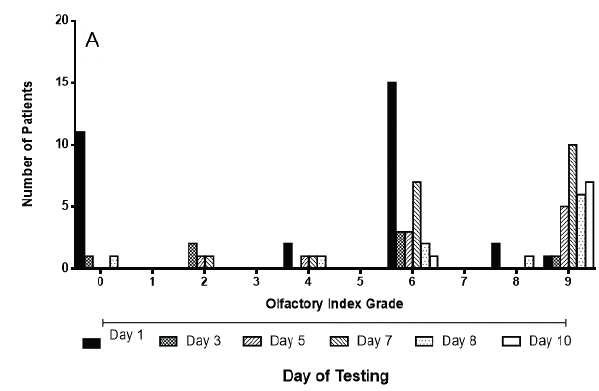
Figure 1. RT-PCR molecular analysis under SARS-CoV-2 infection. RT-PCR molecular analysis was performed multiple times to each patient until testing become negative. Each bar represent the number of patients RT-PCR+ (black) and RT-PCR- (white) through time (days of PCR testing).